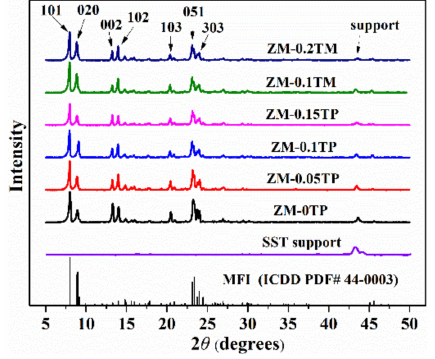
Figure 1. XRD patterns of the HZSM-5 membranes on the stainless steel tube. Table 1. Physical properties and catalytic performances of the zeolite